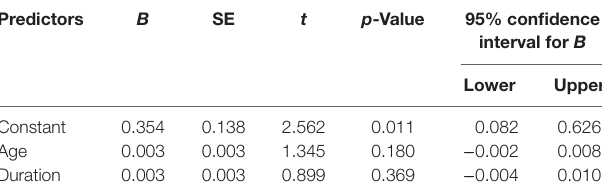
Table 5 | Multivariate analysis of factors associated with adherence.